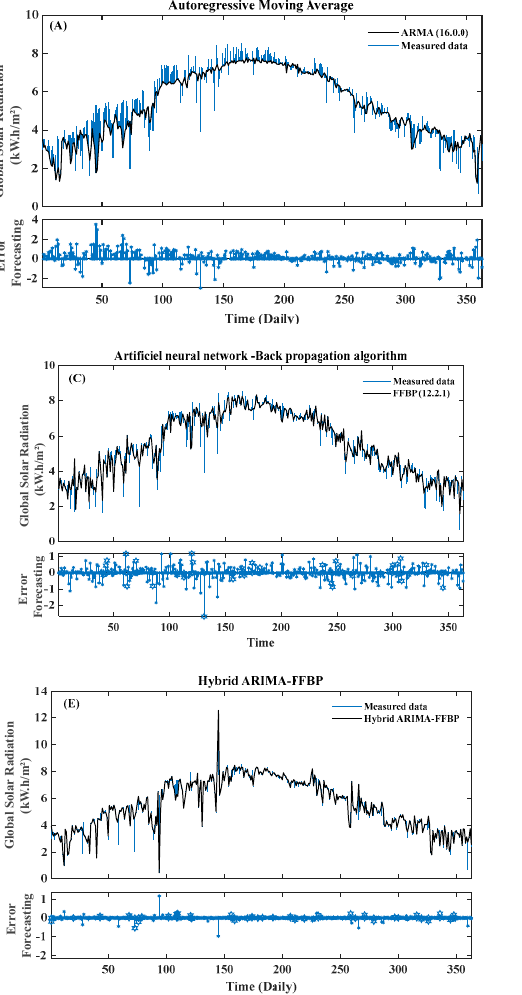
Figure 10. ( A – E ) Comparison between predicted and measured values of daily global solar radiation from ARMA, FFBP, ARIMA, and hybrid models.